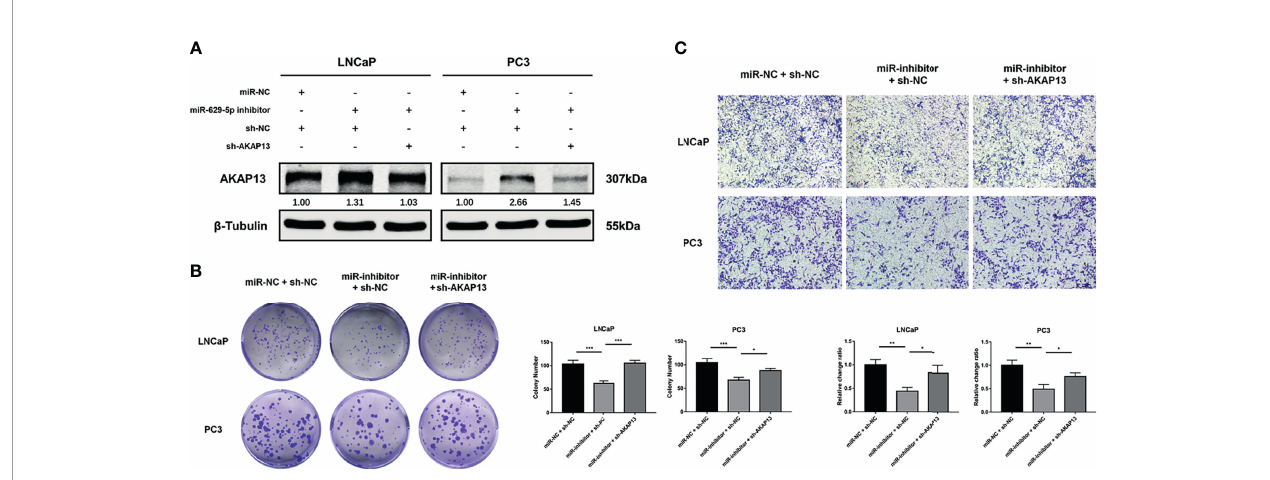
FIGURE 6 | AKAP13 knockdown rescues the miR-629-5p inhibition-attenuated PCa cell proliferation and motility. (A) AKAP13 was knocked down by the shRNA in PCa cells with miR-629-5p inhibition, and the transfection ef fi ciency was con fi rmed by western blotting. (B) Colony formation assays and (C) Transwell assays were performed to assess the proliferation and invasion abilities of PCa cells transfected with the corresponding vectors. The data were presented as means ± SD from three biological replicates. *P < 0.05; **P < 0.01; ***P < 0.001. Student ’ s t-test.